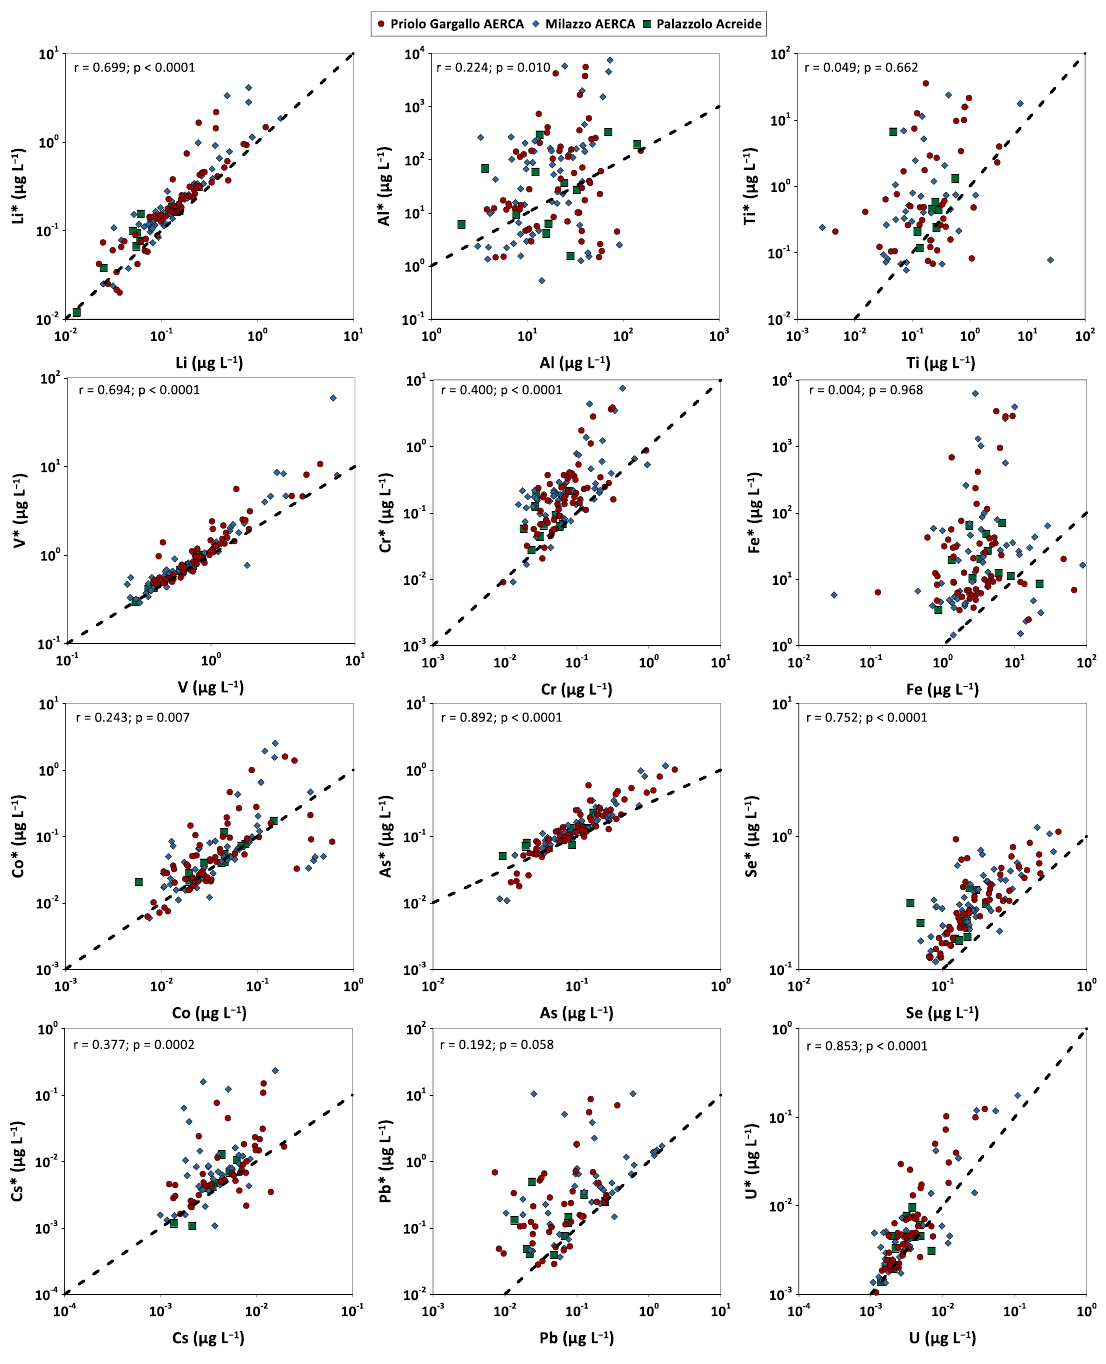
Figure 4. Binary graphs comparing selected trace elements concentrations (μg L −1 ) in the filtered and the unfiltered (*) aliquots. The straight line in each graph indicates the 1:1 ratio between the two concentrations of the specific element.